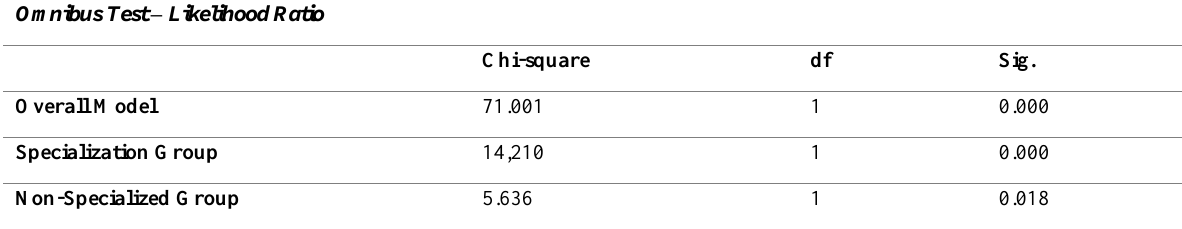
Table 7: Simultaneous Hypothesis Testing